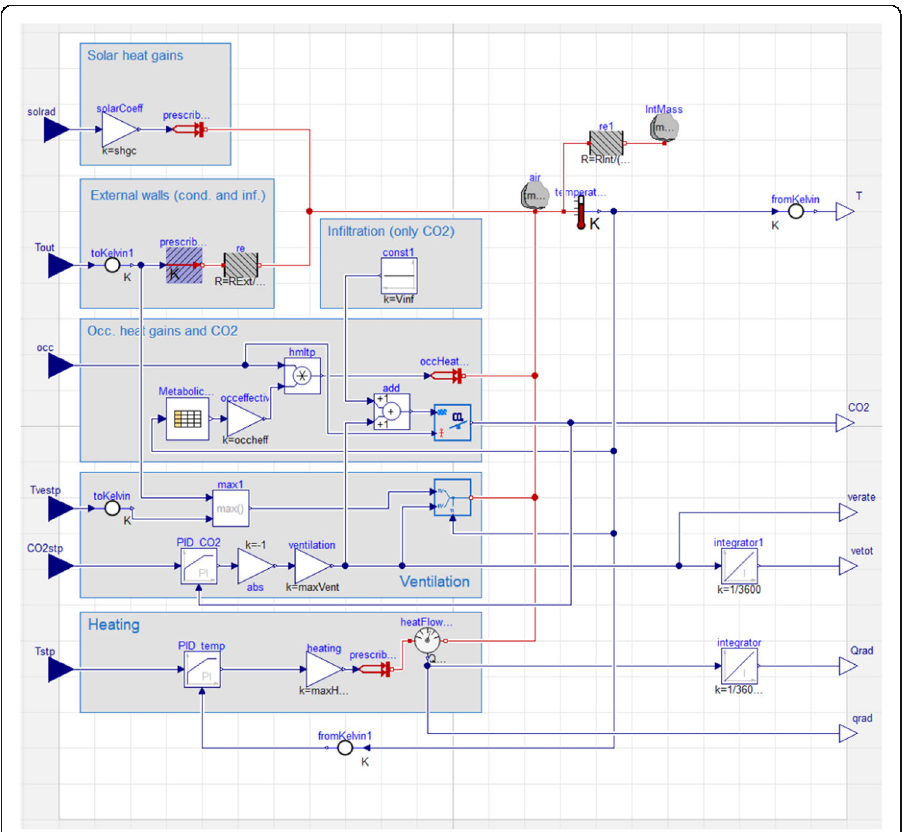
Fig. 3 Zone model implemented in Dymola/Modelica. Inputs to the model are solar radiation, “ solrad ” , measured outdoor temperature “ Tout ” , number of occupants, “ occ ” , Ventilation air temperature setpoint, “ Tvestp ” , CO2 setpoint, “ CO2stp ” and temperature setpoint, “ Tstp ” . The output of the model is resulting temperature, “ T ” , resulting CO2 level, “ CO2 ” , the rate of airflow from the ventilation system “ verate ” , the total airflow over the model simulation period, “ vetot ” , the supplied heat per second, “ qrad ” , and the total supplied heat “ Qrad